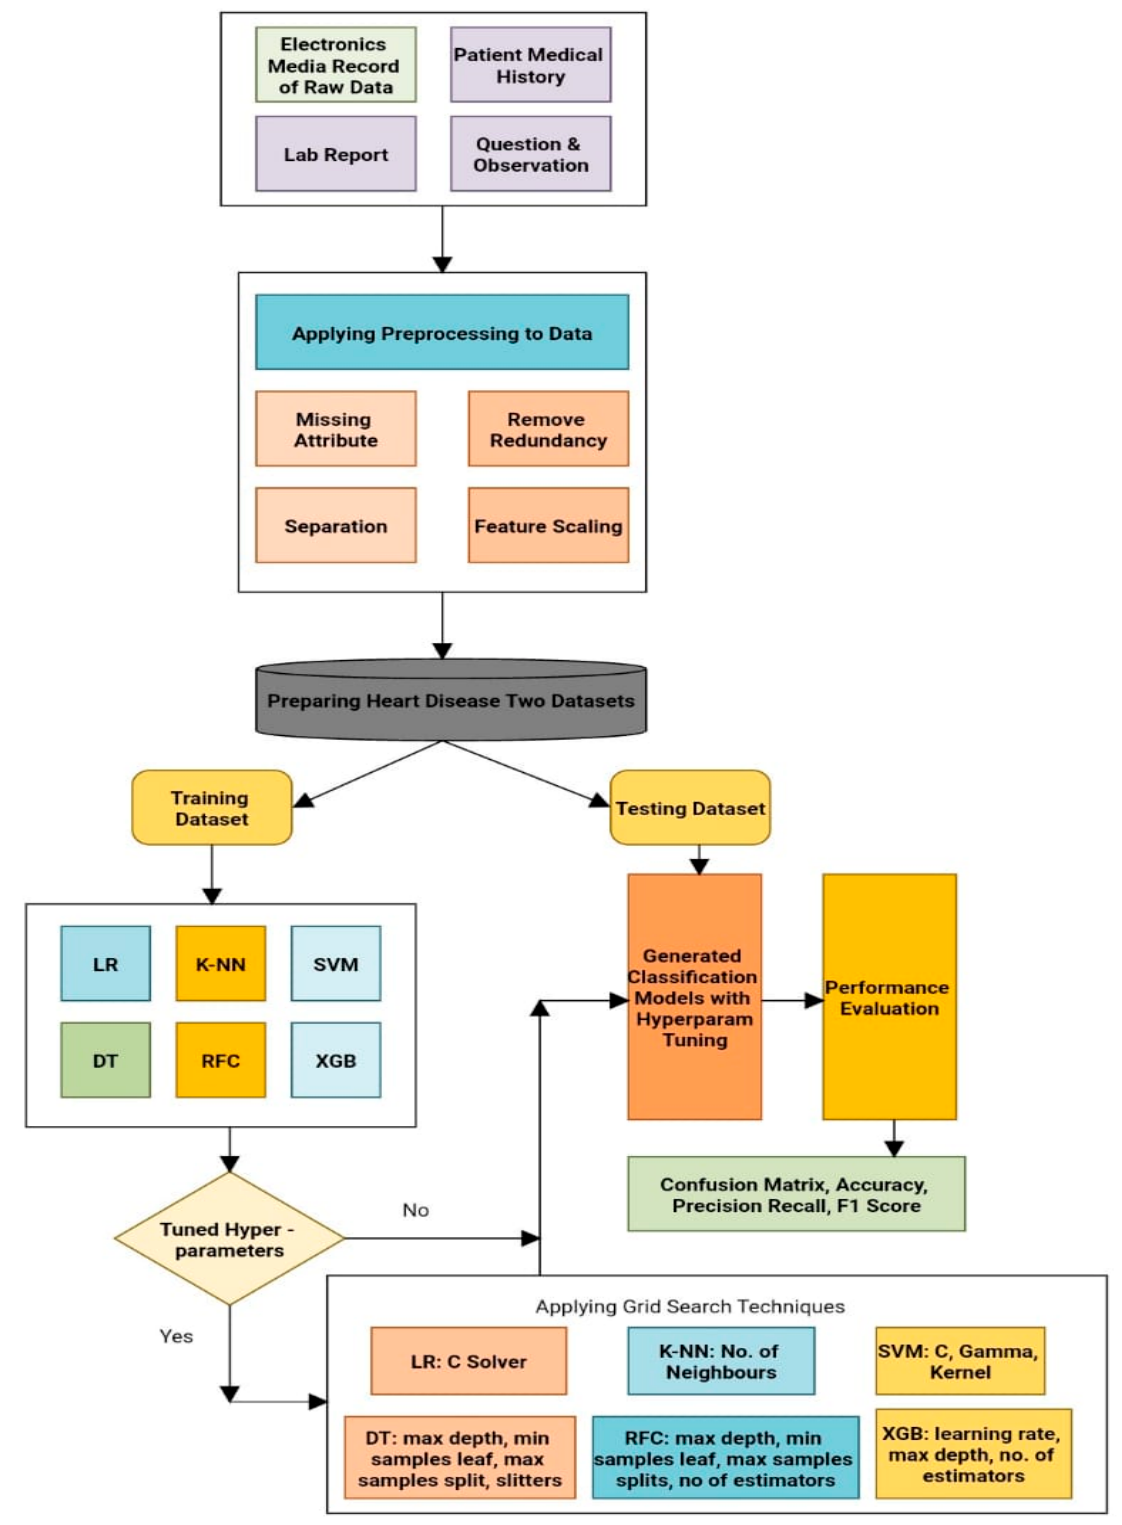
Figure 1. Suggested model with and without tuned hyperparameters.